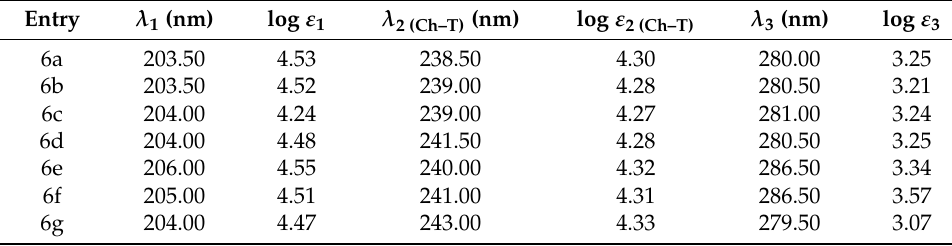
spectrum from 190 to 820 nm and logarithms of molar absorption coefficients (log ε 1 , log ε 2 (Ch–T)